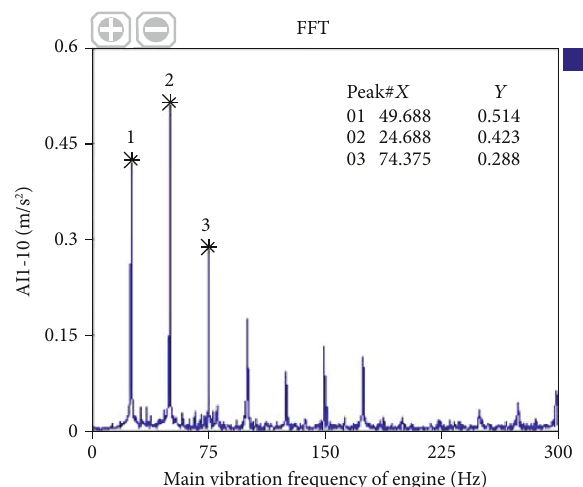
Figure 3: Spectrum of the idle small-throttle engine.